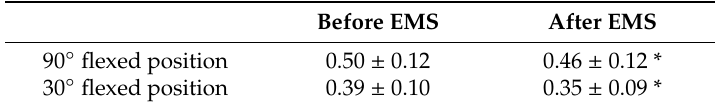
Table 1. Each TT peak value (Nm / kg) at 90 ◦ and 30 ◦ knee flexion angle. Before